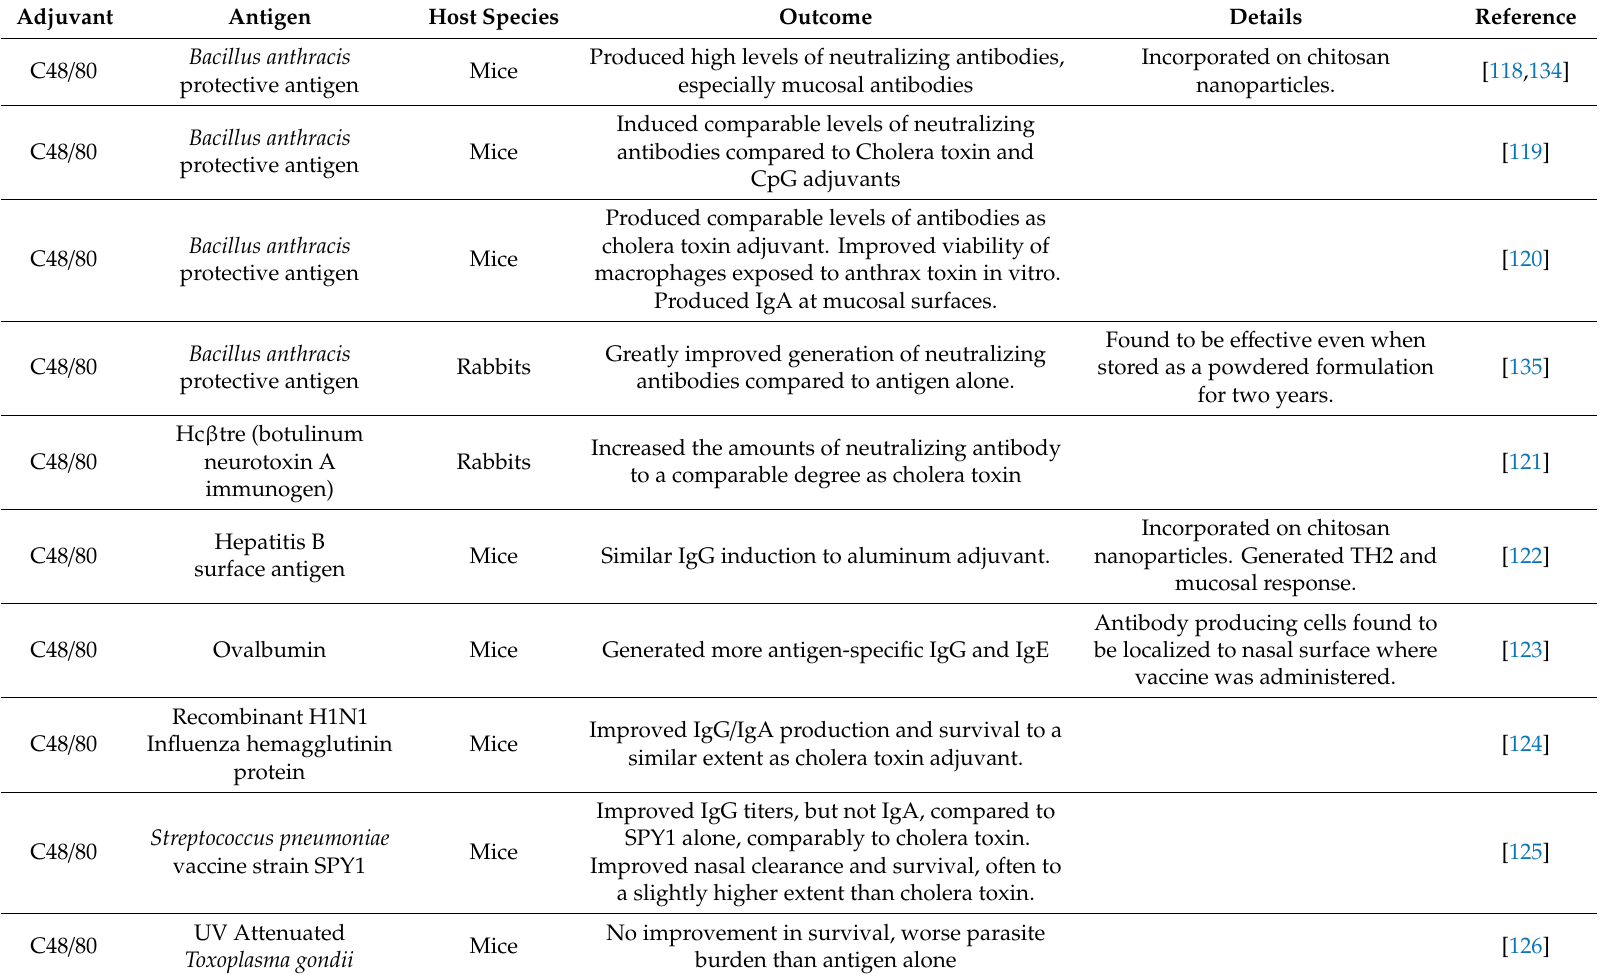
Table 1. Vaccine studies using adjuvants that target mast